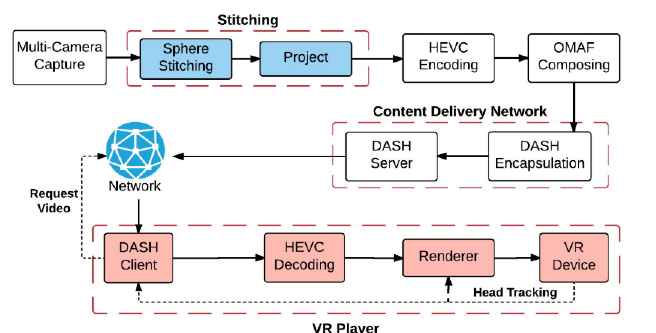
Figure 2. Dynamic adaptive HTTP streaming (DASH) Omnidirectional Media Format (OMAF) architecture